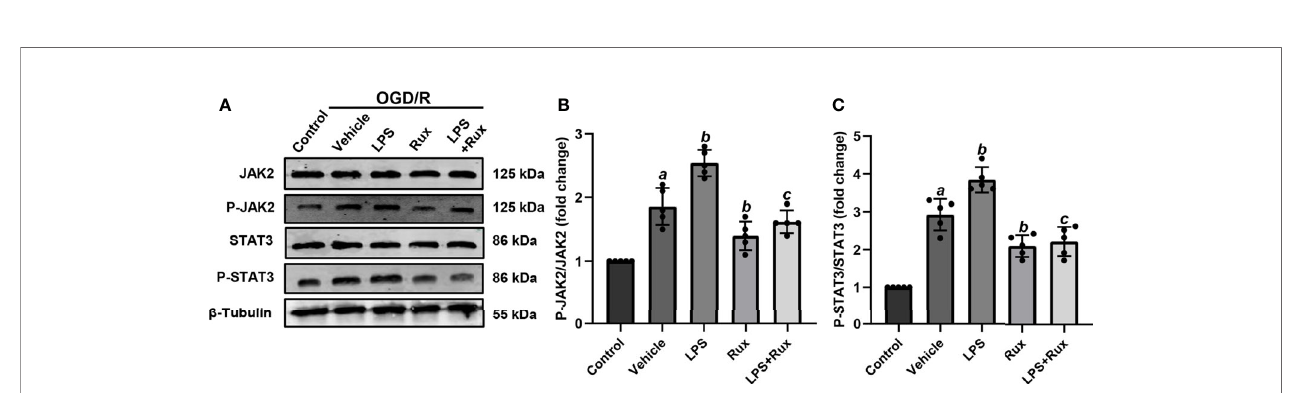
FIGURE 11 | Rux treatment inhibited LPS-induced JAK2/STAT3 activation in HT22 cells after OGD/R. (A) Representative western blots showing that Rux administration downregulated P-JAK2/P-STAT3 expression in HT22 cells after OGD/R. (B, C) Quanti fi cation of P-JAK2 and P-STAT3 presented as fold changes. Means ± SD. n = 5/group. a P < 0.01 versus control; b P < 0.05 versus OGD/R + vehicle; c P < 0.01 versus OGD/R +